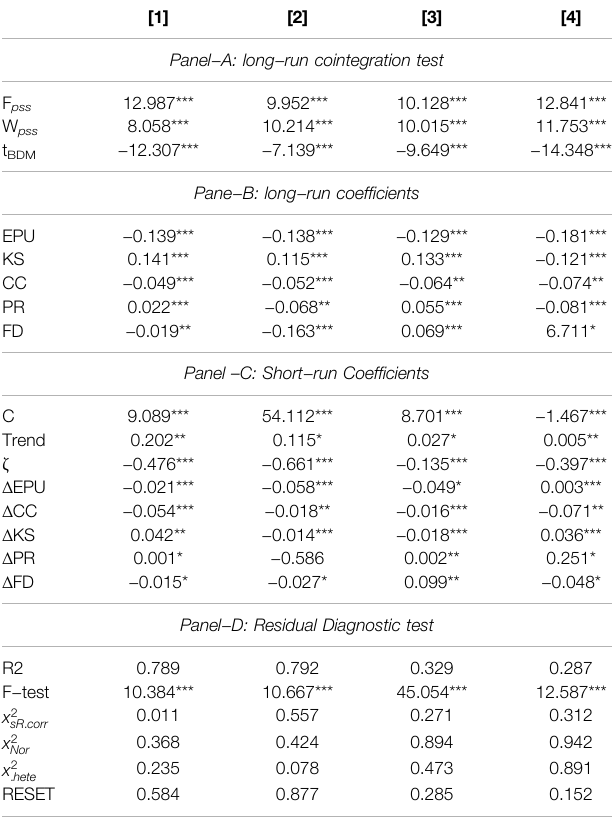
TABLE 6 | Results of autoregressive distributed